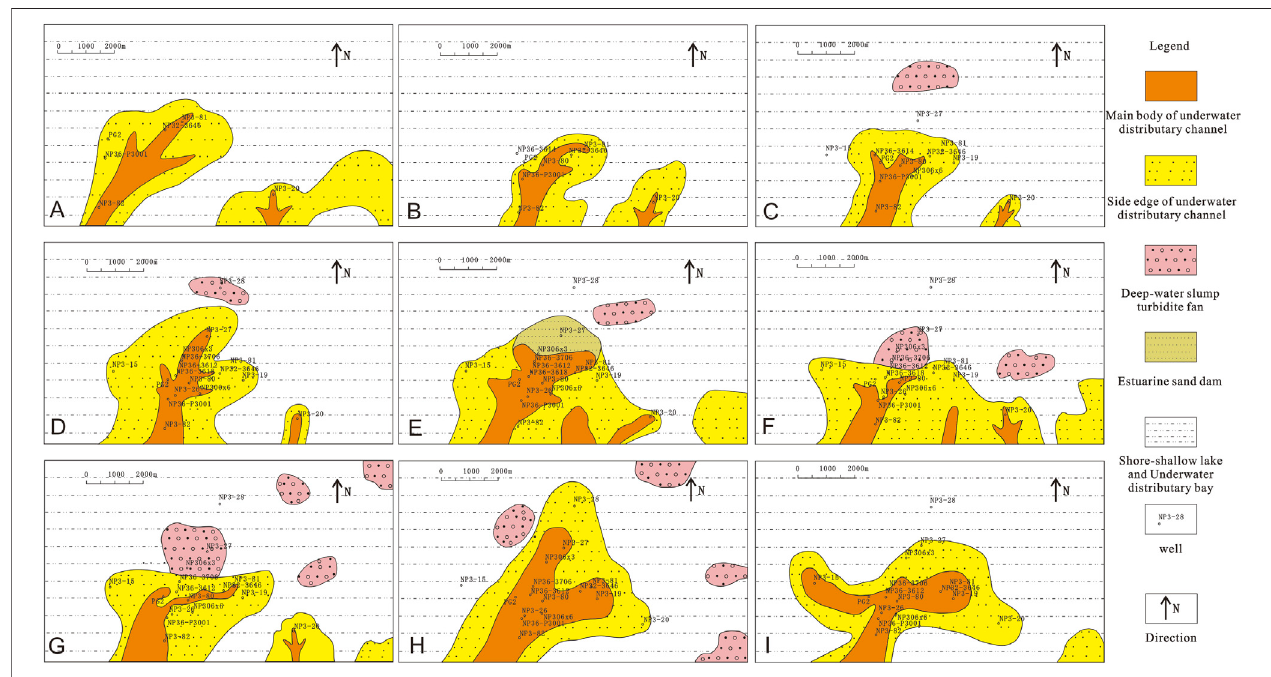
FIGURE 6 | Sedimentary microfacies of SQ1 to SQ7 system tracts in the Nanpu No. 3 structural area. (A) Sedimentary microfacies of SQ1 and SQ2; (B) Sedimentary microfacies of SQ3 transgressive system tract; (C) Sedimentary microfacies of SQ3 regressive system tract; (D) Sedimentary microfacies of SQ4 transgressivesystemtract; (E) SedimentarymicrofaciesofSQ4regressivesystemtract; (F) SedimentarymicrofaciesofSQ5transgressivesystemtract; (G) Sedimentary microfaciesofSQ5regressivesystemtract; (H) SedimentarymicrofaciesofSQ7lowstandsystemtract; (I) SedimentarymicrofaciesofSQ7highstandsystemtract.